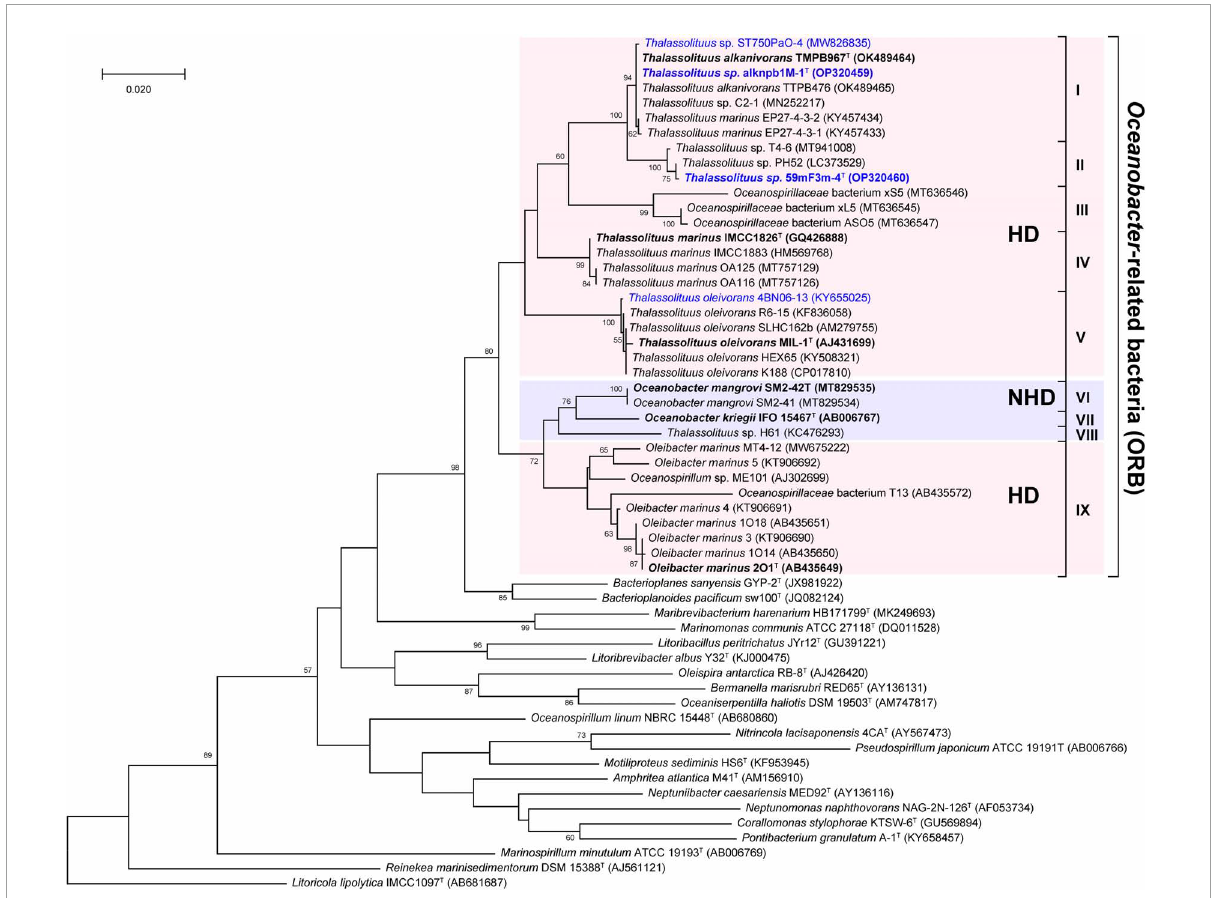
FIGURE1 Maximum-likelihood tree showing the phylogenetic relationships of Oceanobacter -related bacteria along with other type strains of type species within the family Oceanospirillaceae based on 16S rRNA gene sequences. Bootstrap values (expressed as percentages of 1,000 replicates) are shown at branch points. Strains isolated in this study and the type strains of ORB are highlighted in blue and black bold, respectively. Bar, 0.02 nucleotide substitution rate (Knuc) units. Litoricola lipolytica IMCC1097 T (AB681687) was used as the